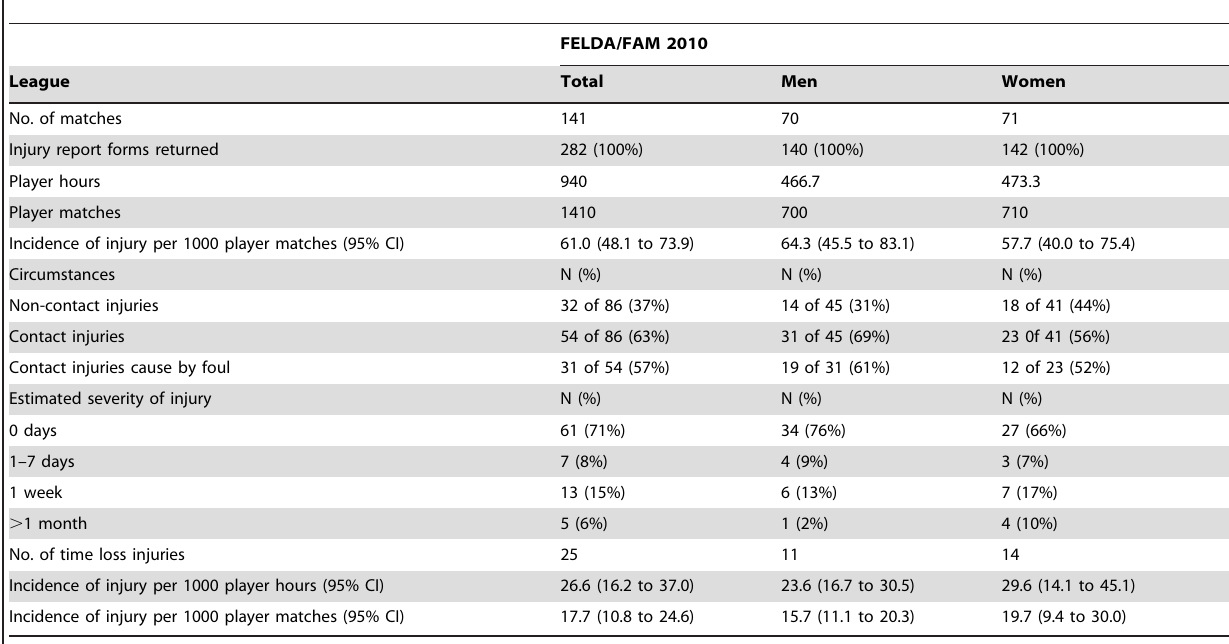
Table 2. Incidence and characteristics of injury during the FELDA/FAM National Futsal League 2010.